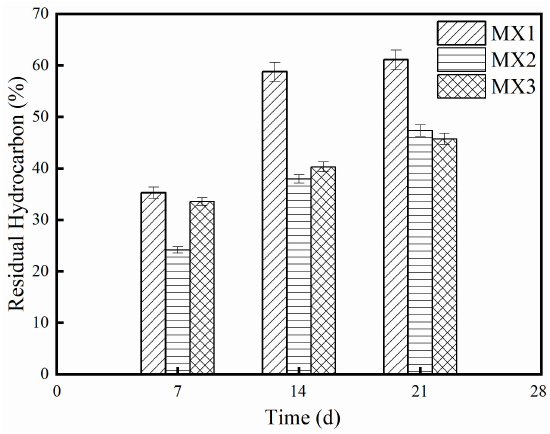
Figure 1. The screening of the oil-degrading bacteria.